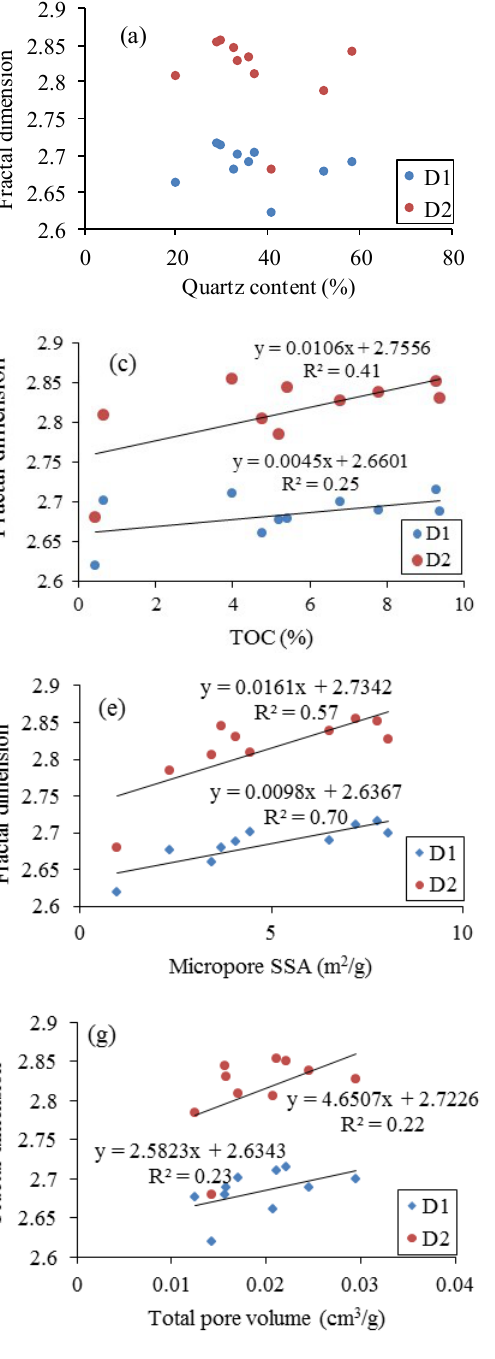
Figure 14. Relationship between fractal dimensions and shale composition ( a–c ) and relationship between fractal dimensions and structure parameters ( d–h ).